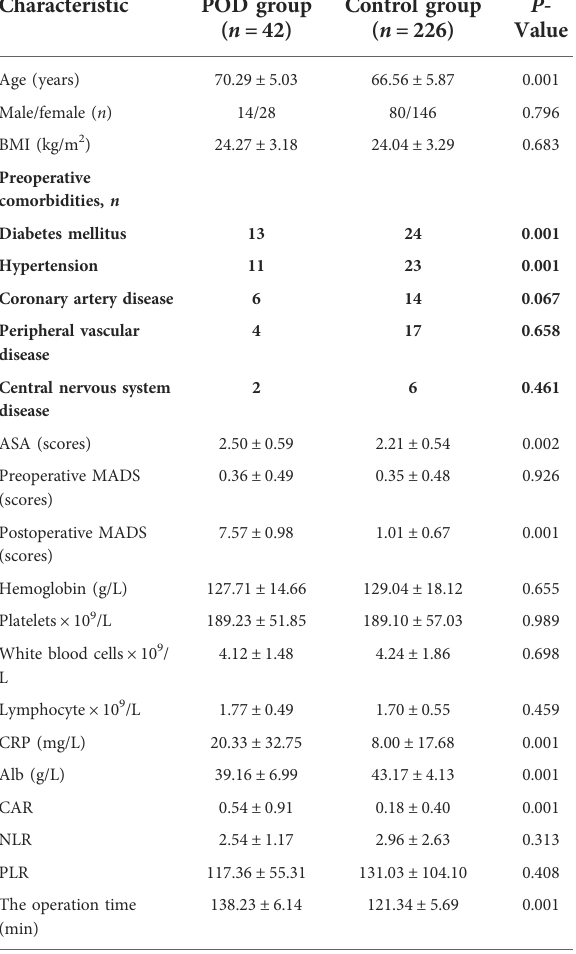
TABLE 1 Demographic and clinical parameters of the POD and control group.